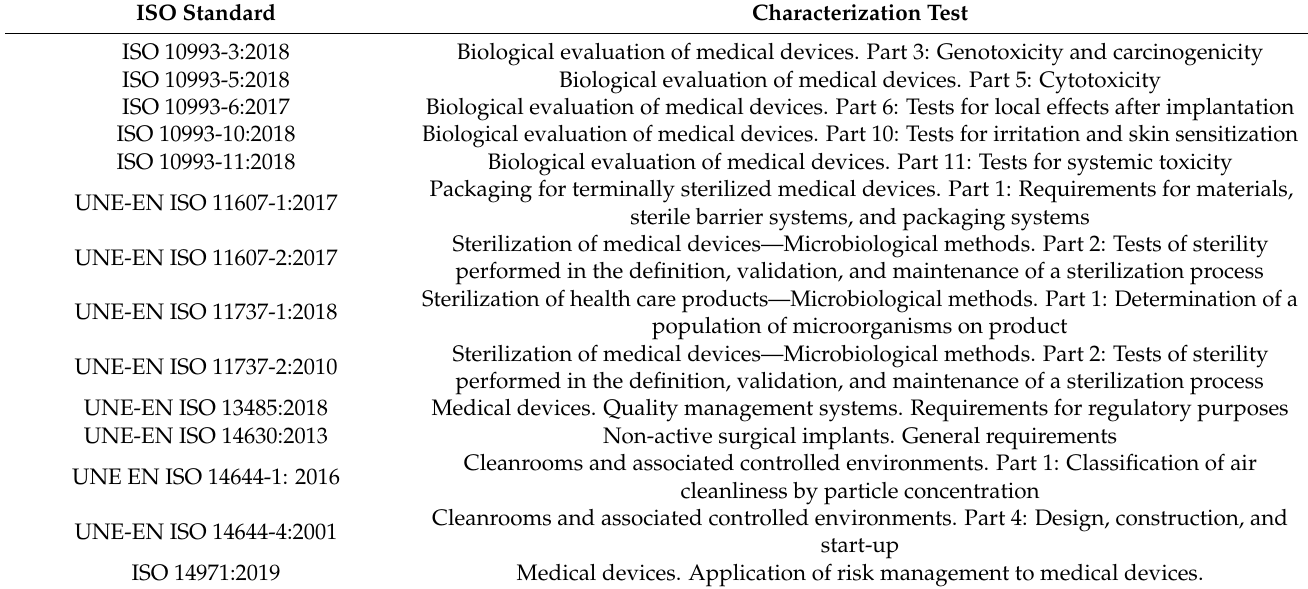
Table 3. Test to comply with regulation of medical